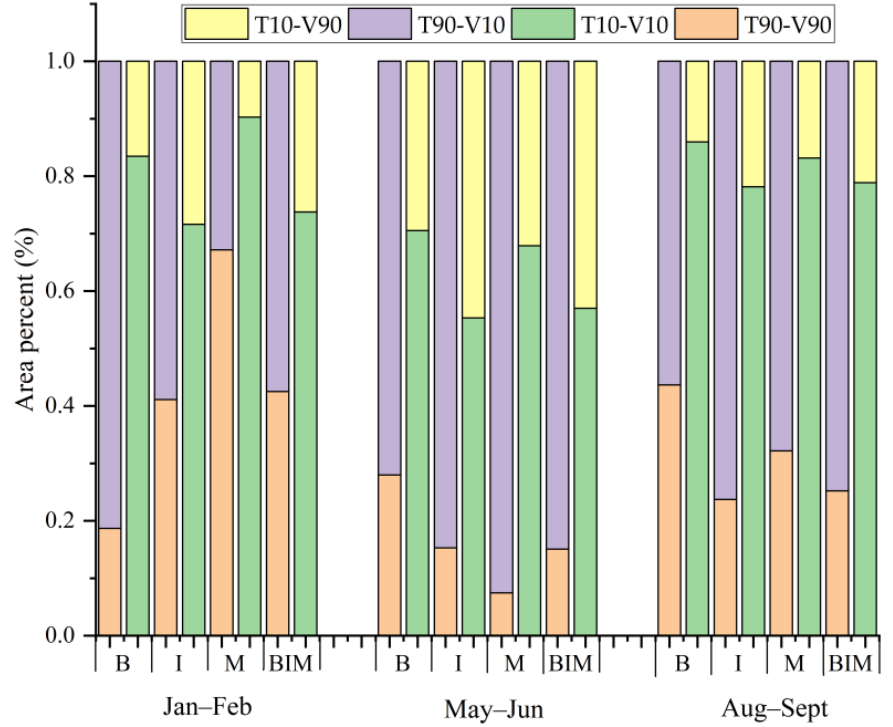
Figure 7. The area proportions of significant event coincidence rates (SCRs) between different combinations of extremes; lower (the 10th quantile) and higher (the 90th quantile) temperature (T 10 and T 90 ) and vegetation index (V 10 and V 90 ) in the three growing periods for Bangladesh (B), India (I), Myanmar (M) and the entire region (BIM). Table 5. Significant event coincidence rates (SCRs) between different combinations of extremes; lower (the 10th quantile) and higher (the 90th quantile) temperature (T10 and T90) and vegetation index (V10 and V90) in the three growing periods for Bangladesh (B), India (I), Myanmar (M) and the entire region (BIM).